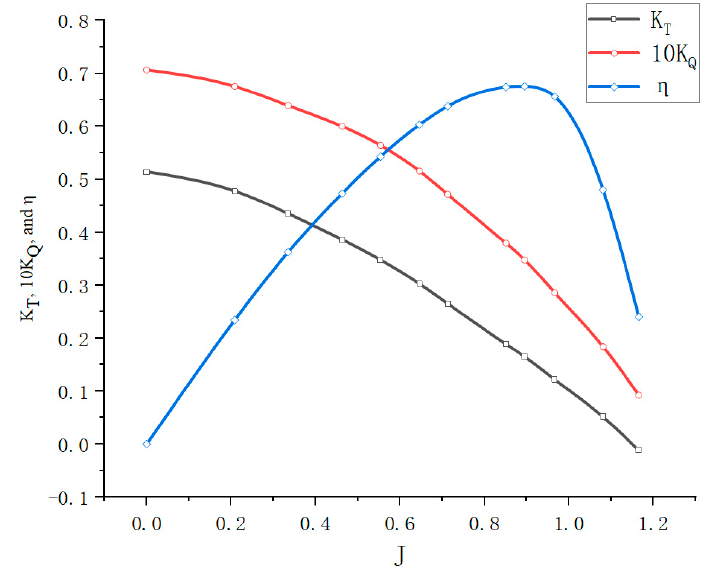
Figure 4. Geometry and lines of the S175 (hull, propeller, and rudder).